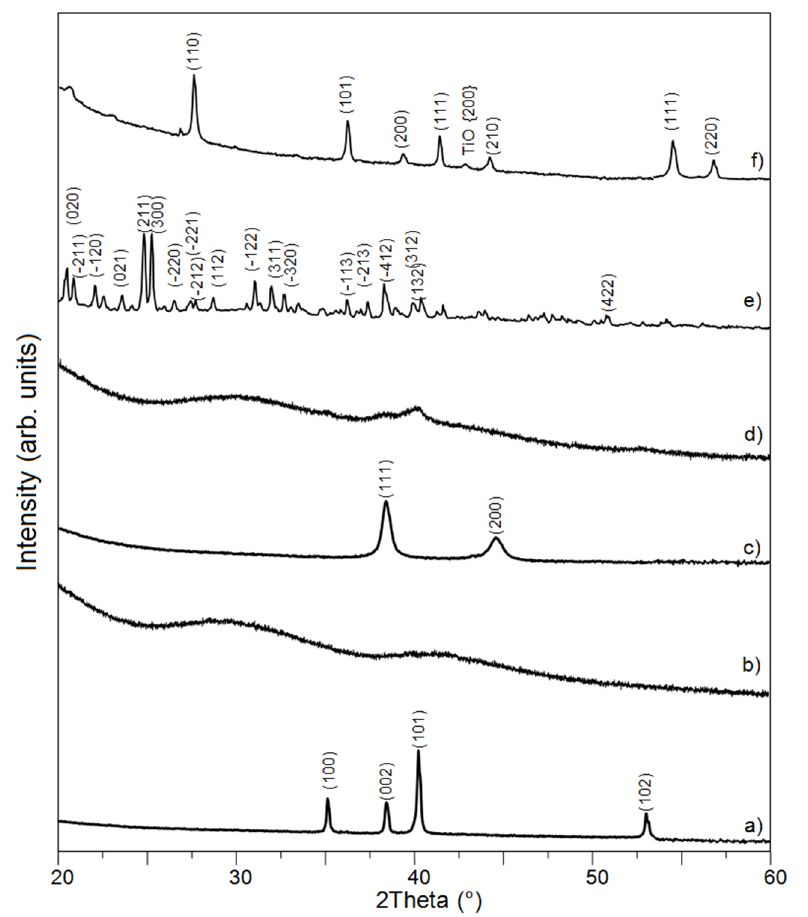
Figure 2. XRD spectra of Ti ( a ); 45S5 Bioglass ( b ) and silver ( c ) powders, their mixture after 15 h of mechanical alloying ( d ); saccharose crystals (C 12 H 22 O 11 )—the space-holder material ( e ) and Ti-10 wt% 45S5 Bioglass-1 wt% Ag nanocomposite foam with porosity of 70% after space holder removing and scaffold sintering in a vacuum of 10 − 2 mbar at 1300 °C for 2 h ( f